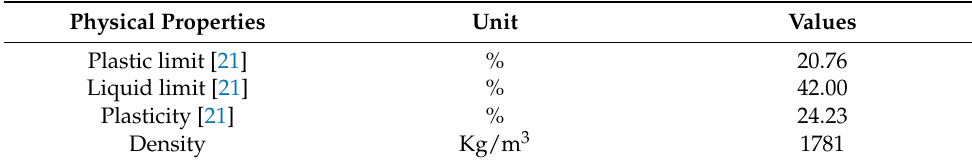
Figure 3. XRD diffractogram of TZ clay. Table 3. Physical properties of TZ clay.